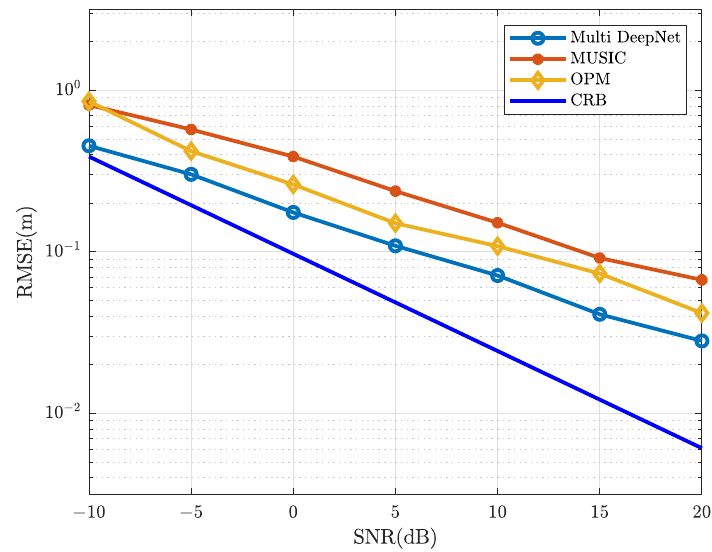
Figure 10. RMSE of range estimation with